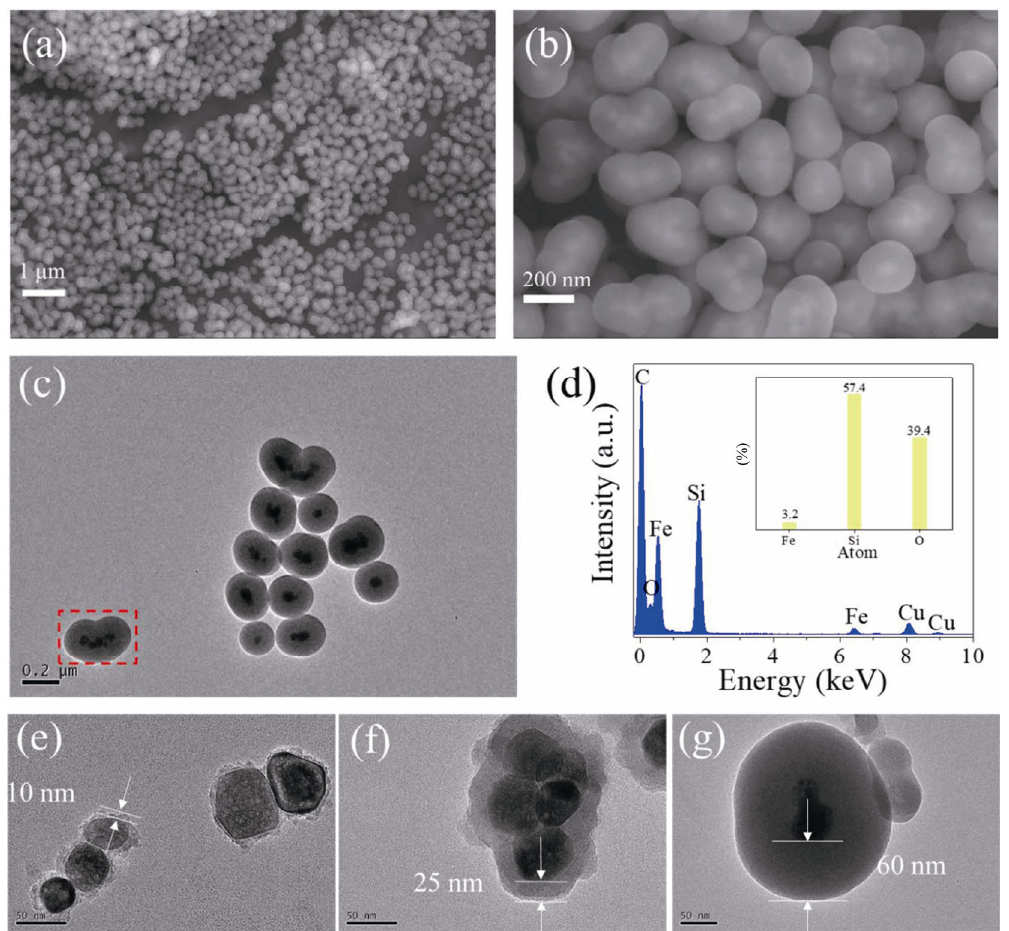
Fig. 3 (a, b) SEM micrographs of α-Fe 2 O 3 @SiO 2 ; (c) TEM micrograph and (d) EDS spectrum of α-Fe 2 O 3 @SiO 2 NPs; TEM images of α-Fe 2 O 3 @SiO 2 with the shell thickness of (e) 10 nm, (f) 25 nm, and (g) 60